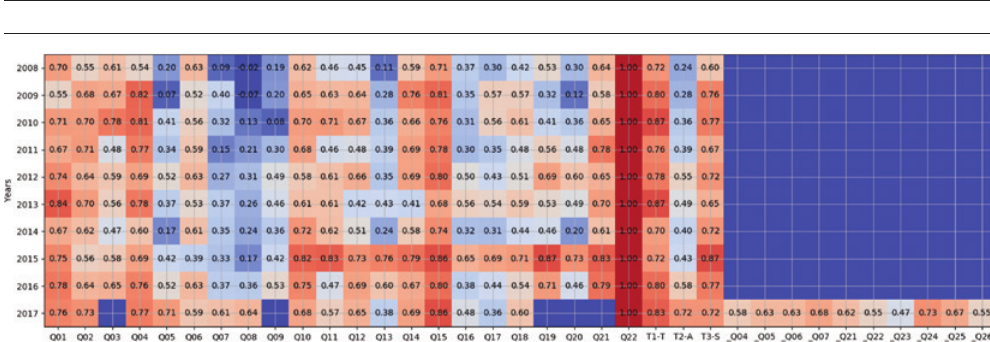
Figure 2: Heat-map of correlations of satisfaction of NSS questions with Q22, in computer science, per year, across the top half of providers by size